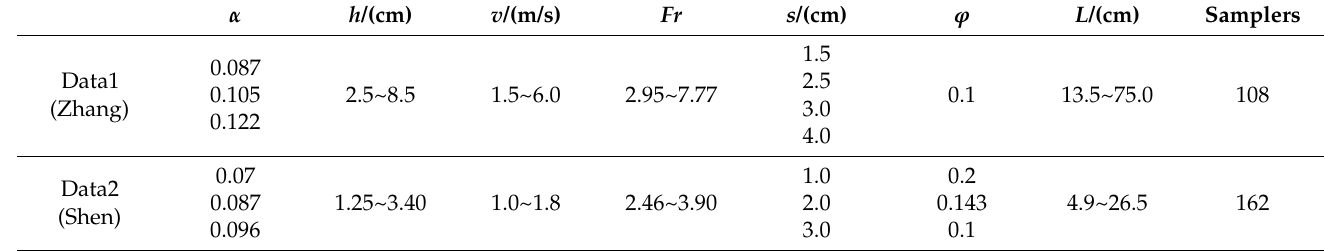
Table 1. Parameter setting in the experiments.